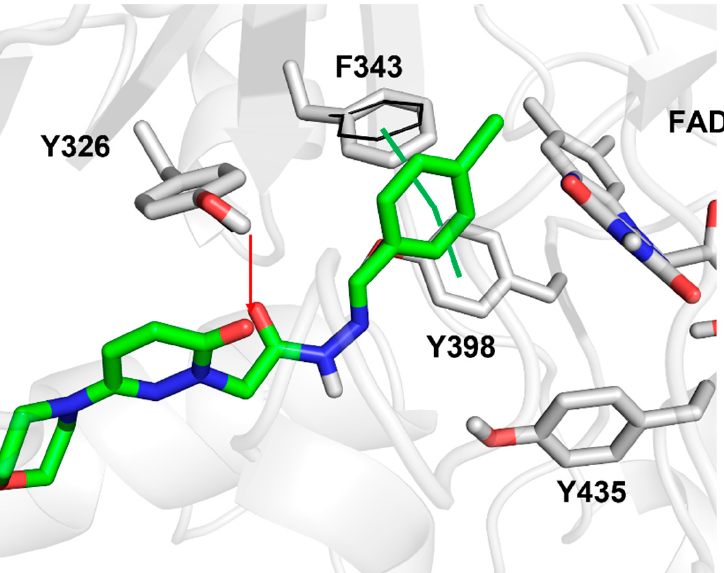
Figure 4. Zoomed in view at MAO-B binding site. Best poses of TR2 ( A ), TR15 ( B ), and TR16 ( C ) were reported as green, cyan, and magenta sticks, respectively. Red arrows and green lines indicate hydrogen bonds and π – π contacts, respectively. For completeness, docking scores returned from simulations were equal to − 10.051, − 9.452 and − 8.558 kcal/mol for TR2 , TR15 and TR16 , respectively.